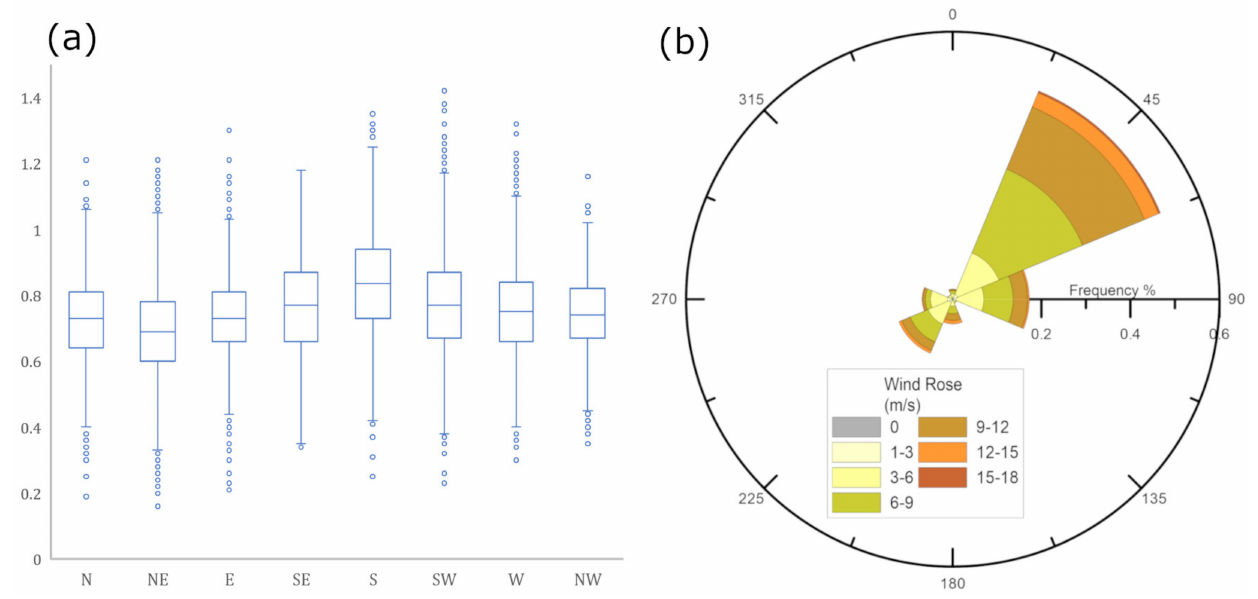
Figure 3. ( a ) Box plots of the sea level for each wind cardinal direction and ( b ) the respective wind